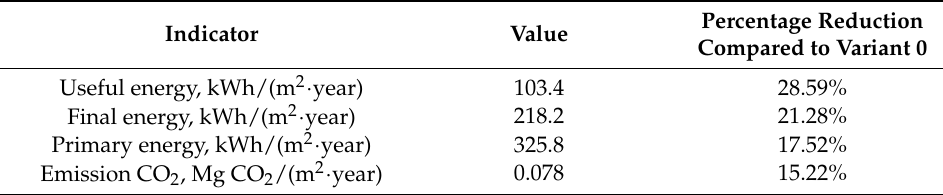
Table 7. Energy performance indicators—variant